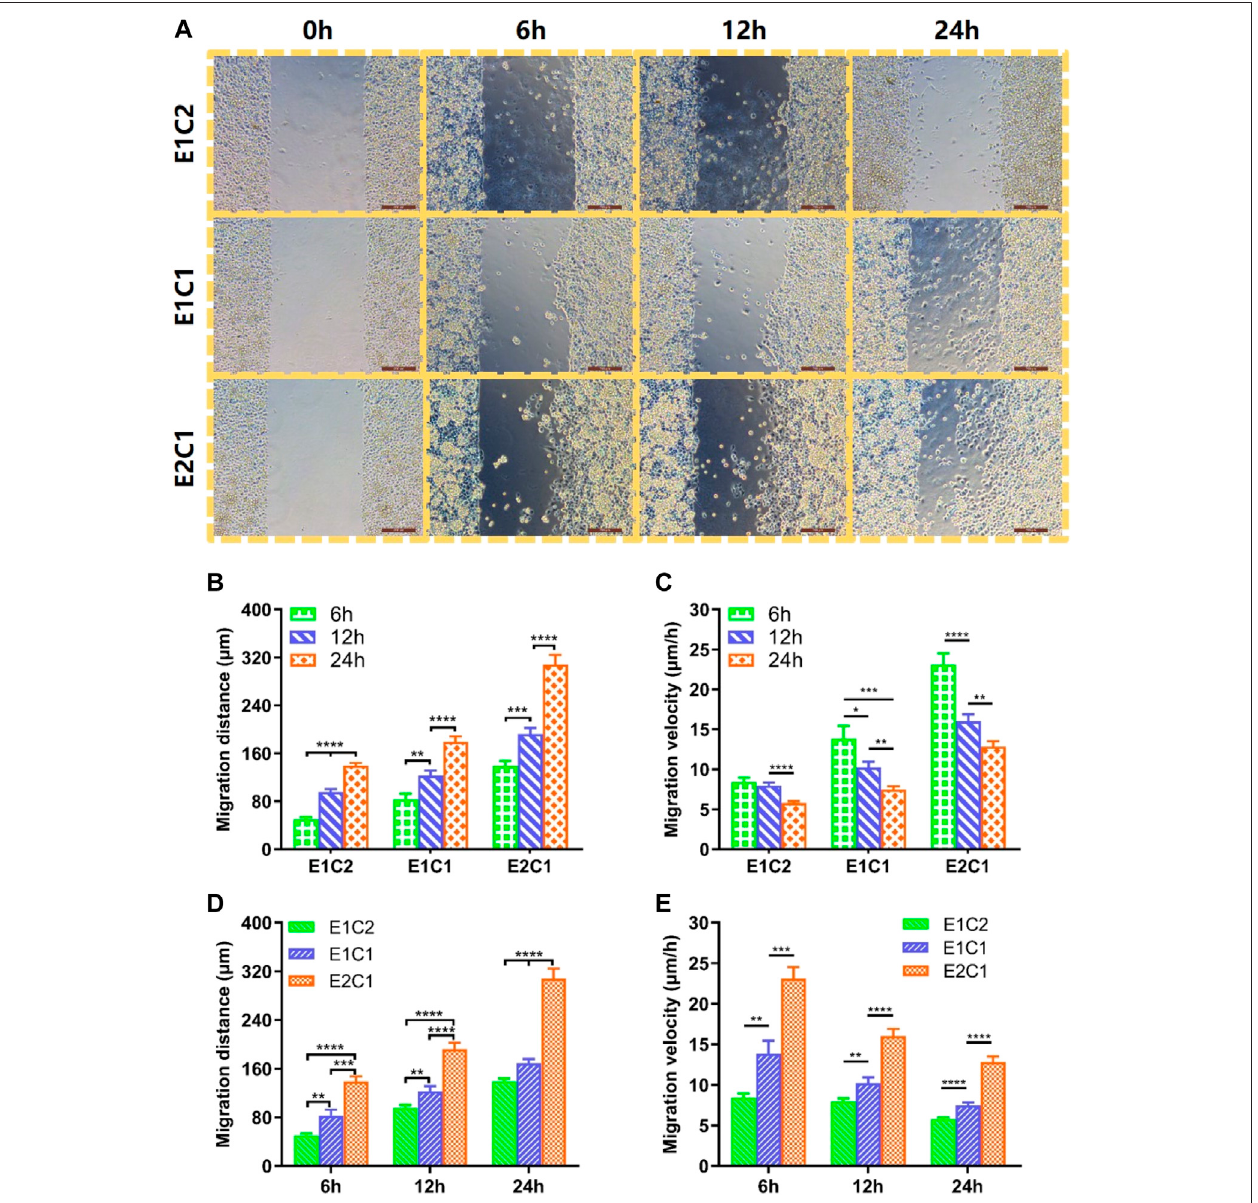
FIGURE11| CellmigrationofRSC96cellsoncellcultureplatesurfacewithdifferentscaffoldsextractcultures. (A) ThemigrationstateofSchwanncellsofallgroups at different time points (scale bar: 200 μ m). (B) Changesin migration distanceofSchwann cells in different groups. (C) Changes inmigration velocity ofSchwann cells in different groups. (D) Migration distance statistics of Schwann cells in the three groups at 6, 12 and 24 h. (E) Migration velocity statistics of Schwann cells in the three groups at 6, 12 and 24 h * p < 0.05, ** p < 0.01, *** p < 0.001, **** p < 0.0001.